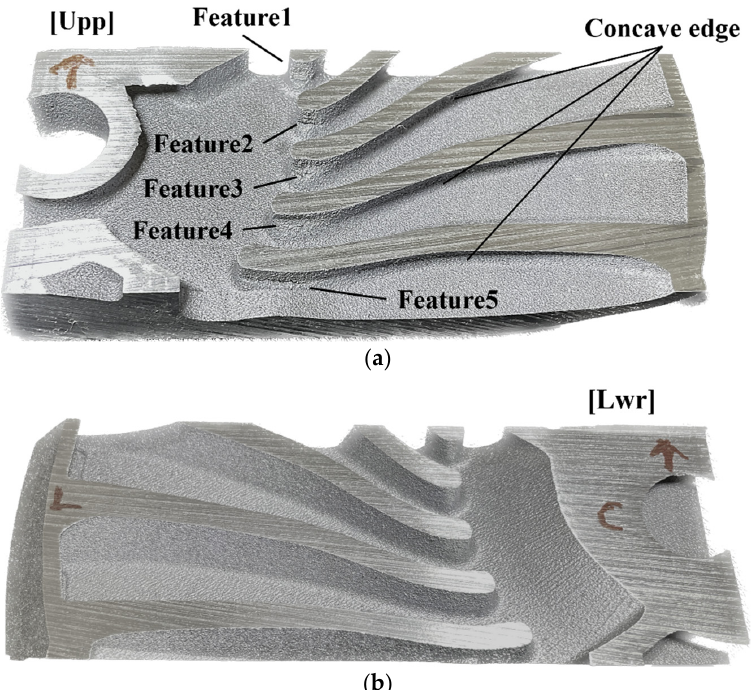
Figure 25. Segmented sample 3 and named features: ( a ) upper region of segmented sample 3 and collapse regions, i.e., feature1, feature2, feature3, feature4, and feature5; ( b ) lower region of segmented sample 3.